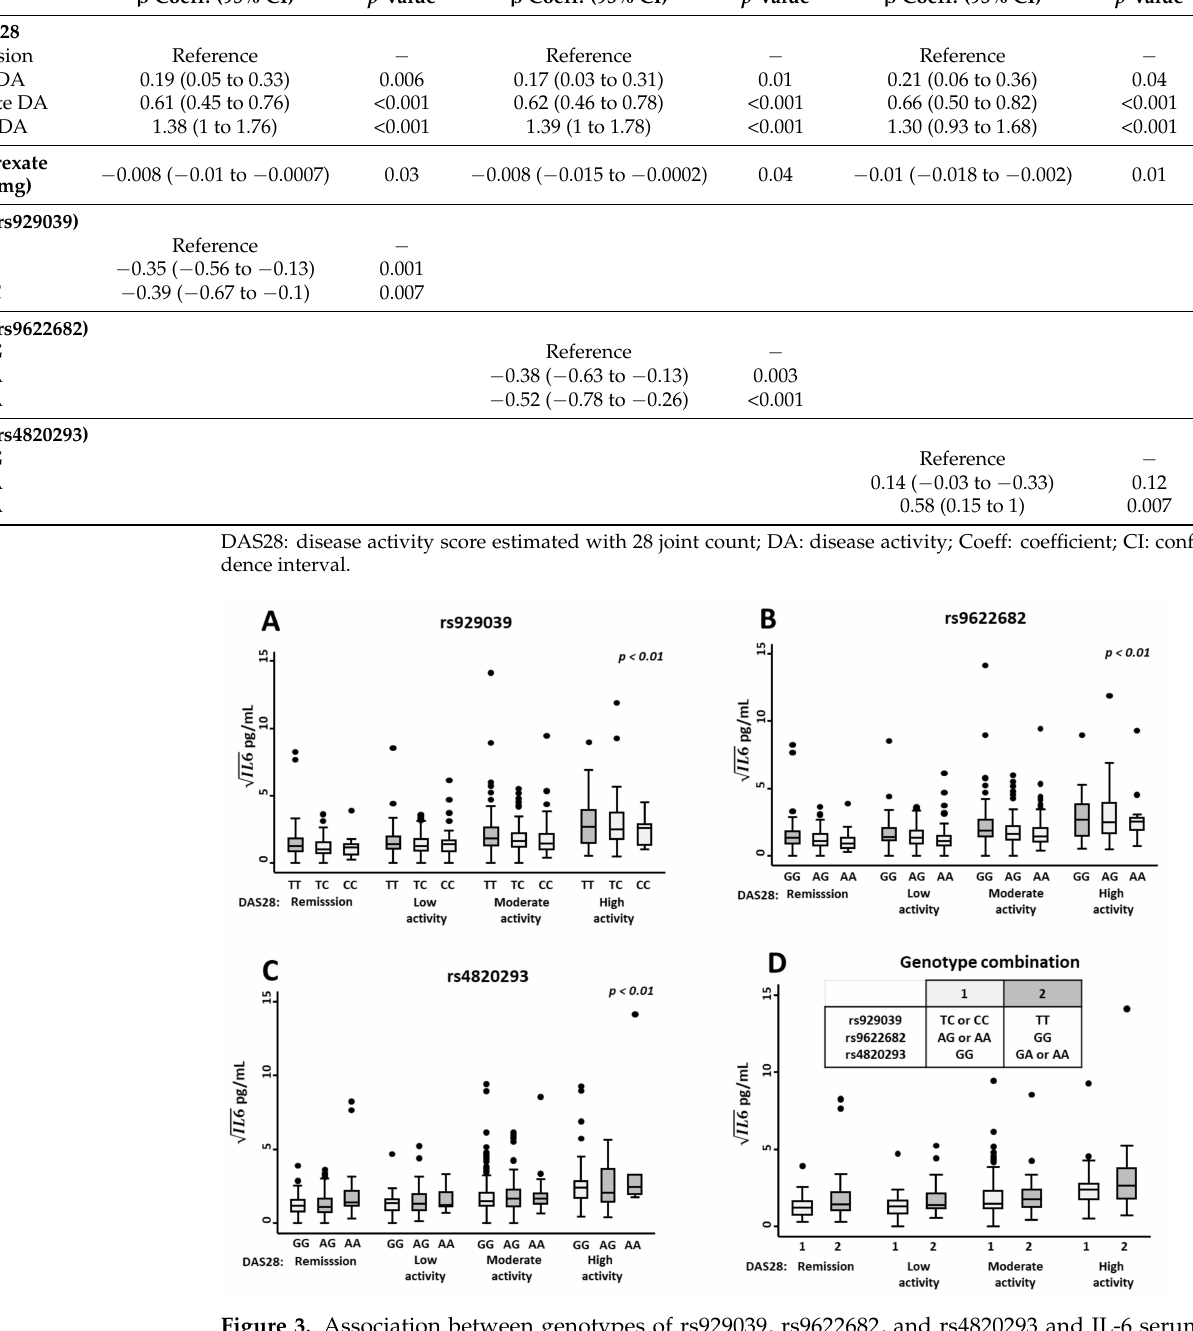
Figure 3. Association between genotypes of rs929039, rs9622682, and rs4820293 and IL-6 serum levels in early arthritis (EA) patients. Relationship between IL-6 serum levels (pg/mL) measured by ELISA in EA patients from PEARL study categorise by disease activity assessed by DAS28 score and the different genotypes of single nucleotide polymorphisms (SNPs) rs929039 ( A ), rs9622682 ( B ), rs4820293 ( C ) and genotype combination ( D ). Data are shown as interquartile range (p75 upper edge of box, p25 lower edge, p50 midline) as well as the p95 (line above box) and p5 (line below). Dots represent outliers. The statistical significance was determined with the multivariable analysis displayed in Table 2. The significance threshold was set at p <